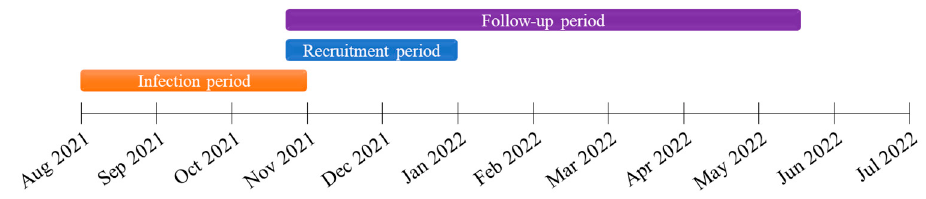
Figure 1. Flowchart of patient enrollment.